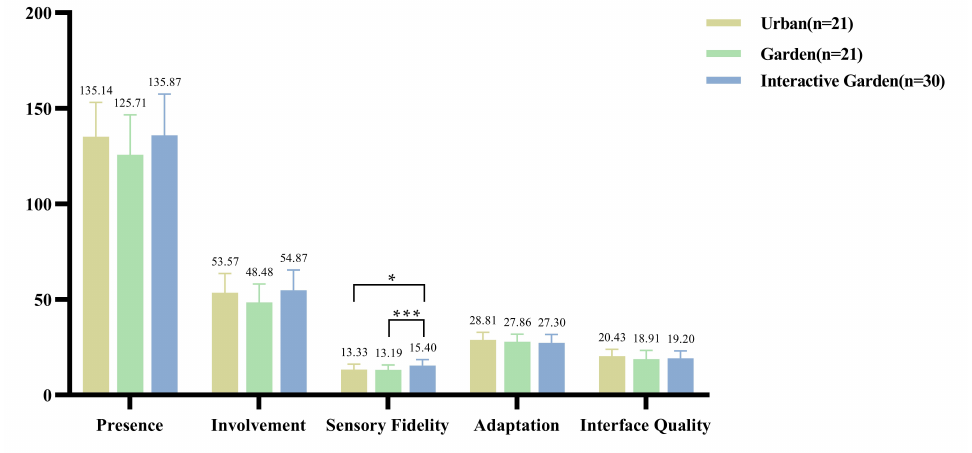
Figure 2. Descriptive statistical results of the total score and each dimension score of the Presence Questionnaire. Note: * represents p < 0.05, *** represents p <